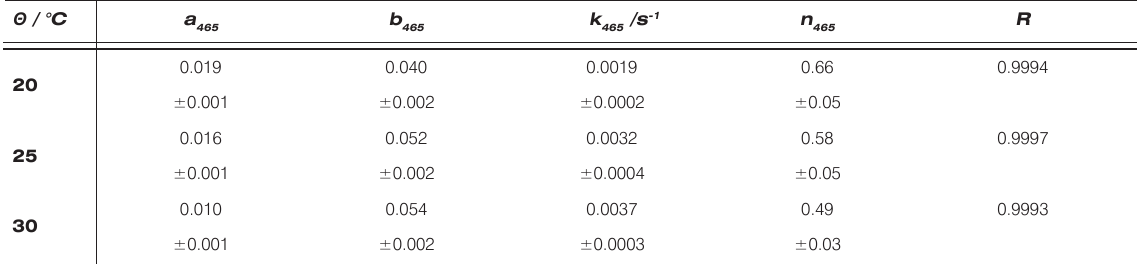
Table 1. Parameters of the kinetic model obtained for the data measured at 465 nm. R - correlation coefficient of non-linear